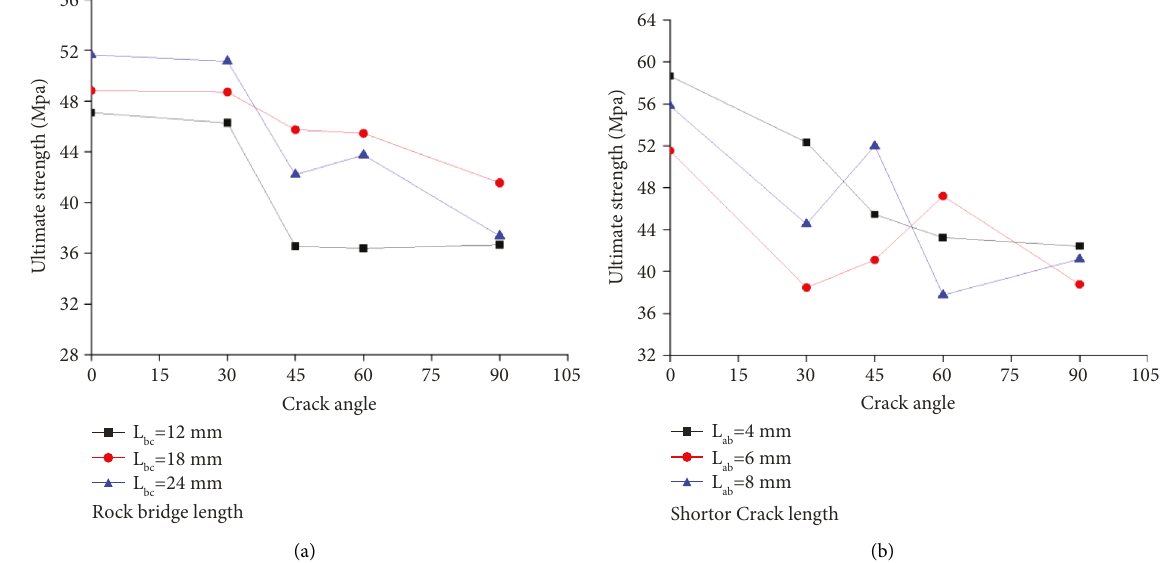
Figure 8: The experimental ultimate strength of specimens versus the rock bridge length: (a) relationship between rock bridge length, crack angle, and ultimate strength and (b) relationship between shorter crack length, crack angle, and ultimate strength.